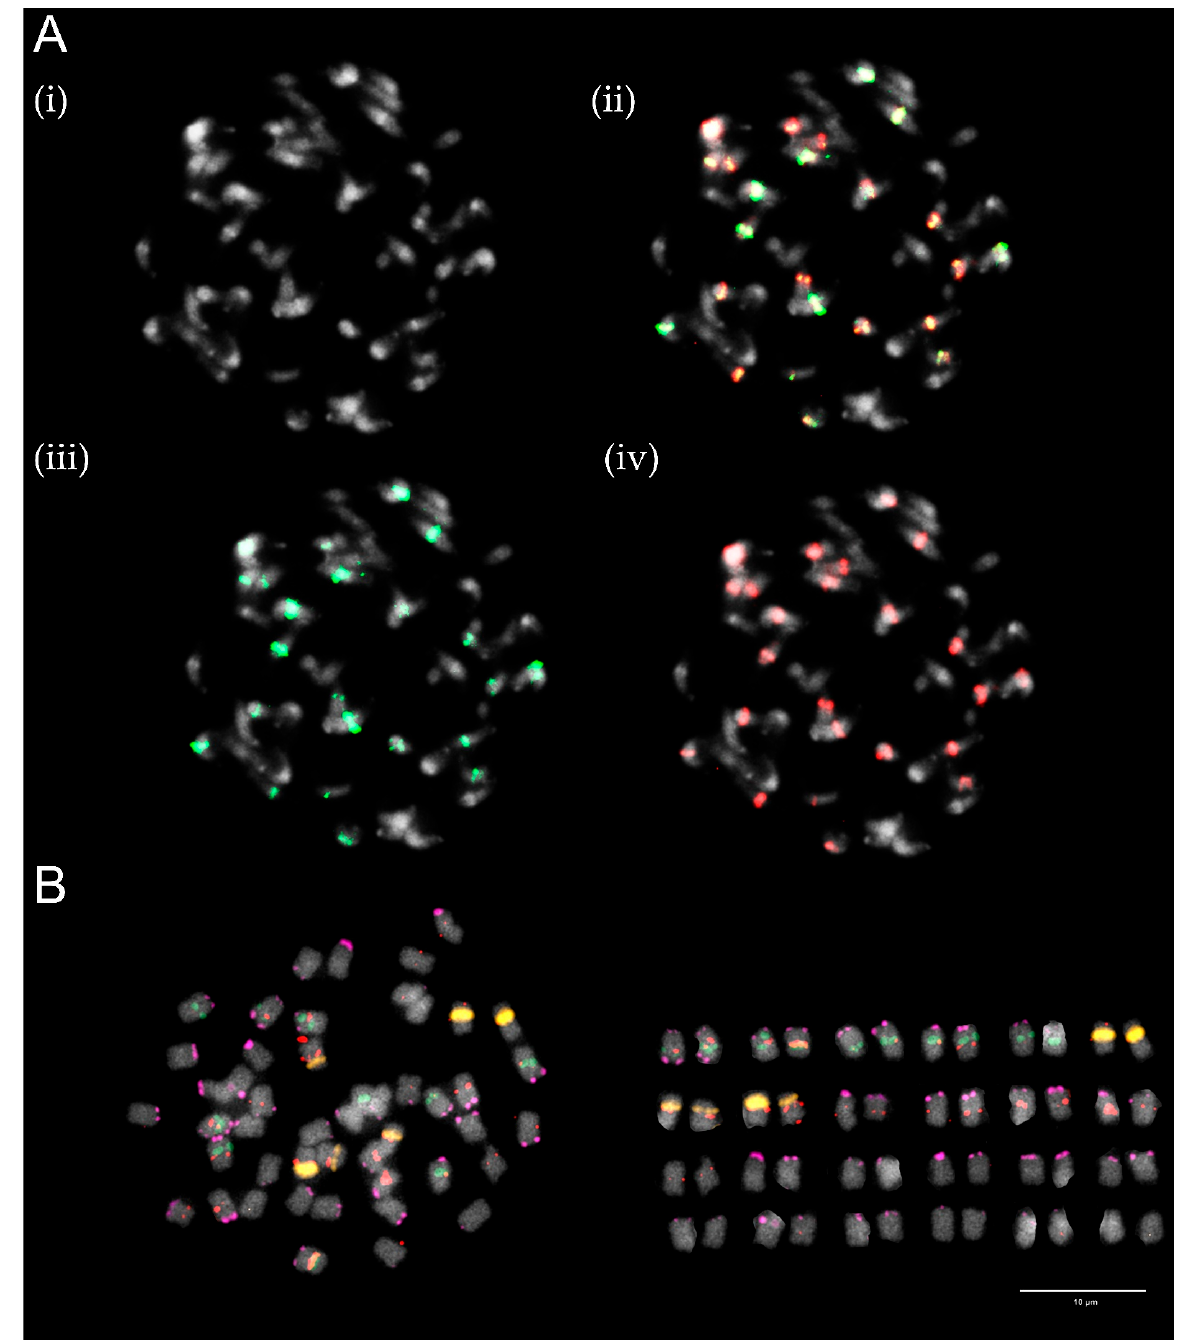
Figure 4. Hybridization pattern of analysed T. medium -specific repetitive elements on metaphase chromosomes of T. medium var. sarosiense . ( A ) Centromeric repeats TrM378 (red) and TrM300 (green). Four pictures are presented; (i) chromosome spread without fluorescent signals, (ii) with merged signals, (iii) with only TrM300 signals and (iv) with only TrM378 signals. ( B ) Centromeric repeat TrM378 (red), subtelomeric repeat TrM179 (pink), 5S rDNA (green), and 26S rDNA (orange). No presence of pericentromeric repeat TrM60 was observed. Scale bar = 10 µ